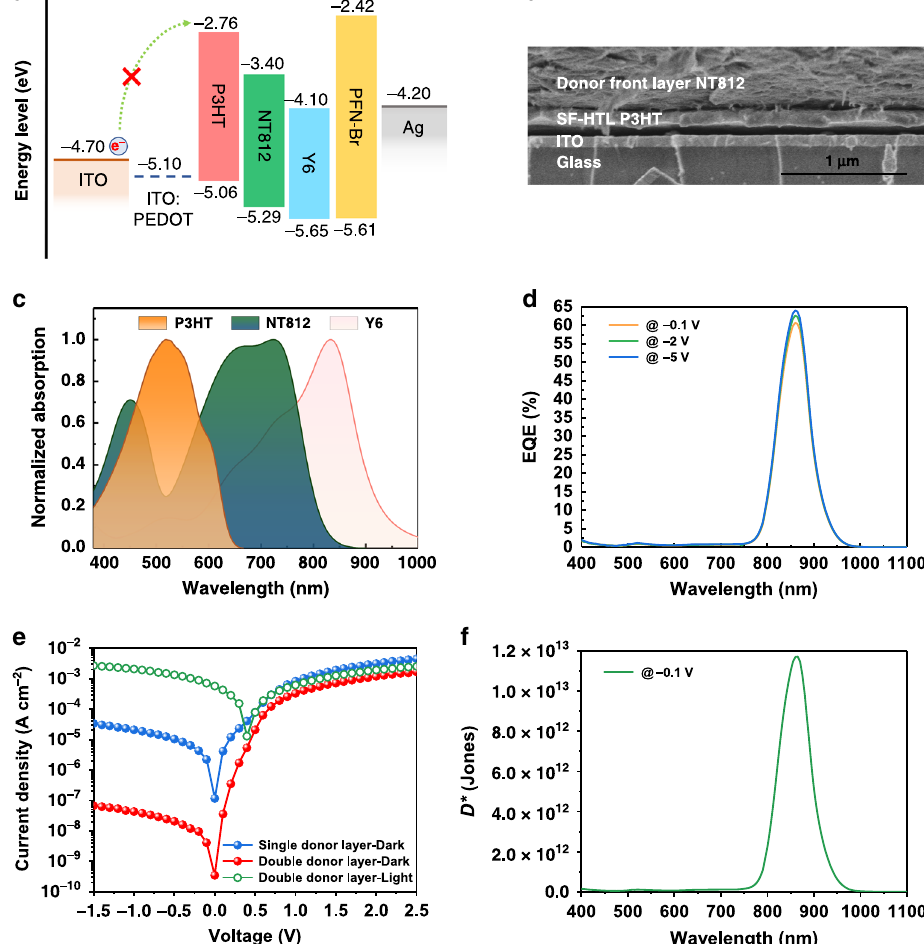
Fig. 3 Device performances of SF-narrowband OPD with double donor layers. a Energy level diagram of materials used to construct self- fi ltering (SF) narrowband organic photodetector (OPD) with double donor layers. b Cross-section scanning electron microscope image of the double donor layer structure, the scale bar identi fi es a length of 1 μ m. c Normalized ultraviolet-visible (UV – Vis) absorption spectra of P3HT, NT812, and Y6. d External quantum ef fi ciency (EQE) curves (at 165 Hz) of the SF-narrowband OPD with double donor layers under different voltage biases as indicated. e Current density – voltage ( J – V ) curves in dark and under illumination. f Speci fi c detectivity spectra obtained from dark current density ( J d